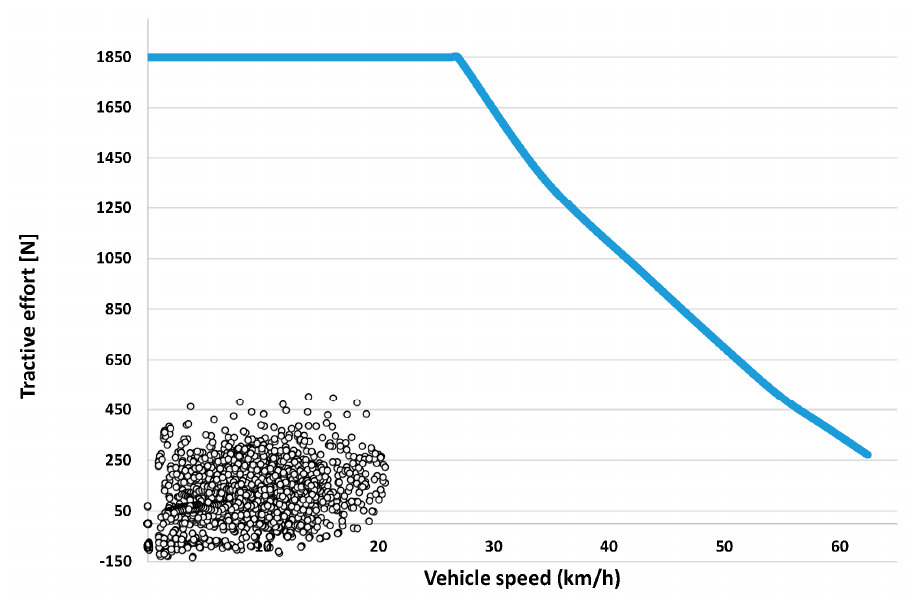
Figure 12. Tractive effort in different operating points for Routes 1 and 2.